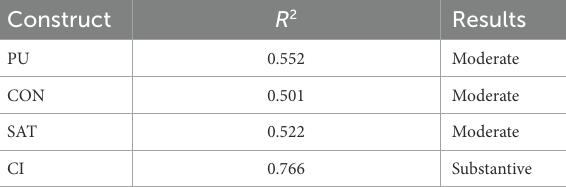
TABLE 7 Coefficient of